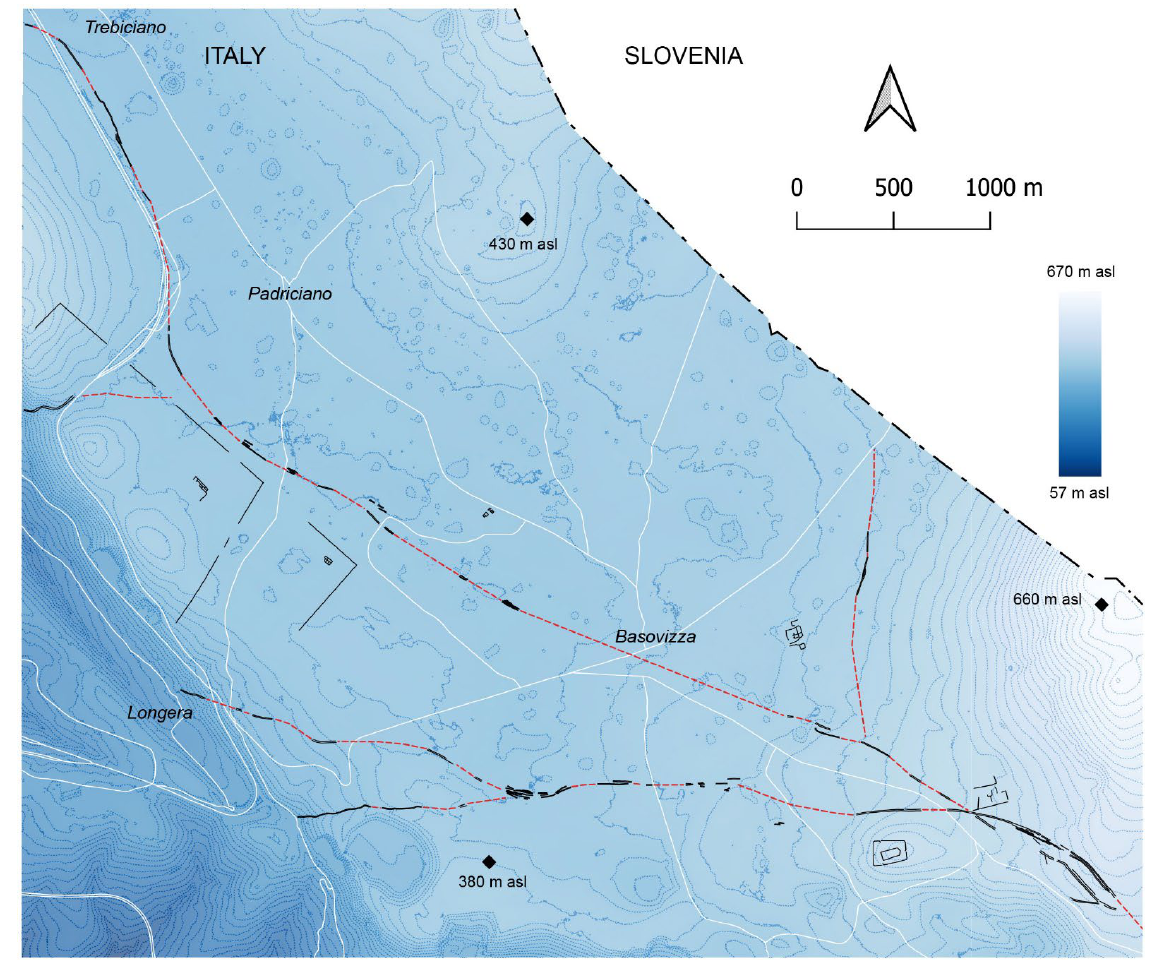
Figure 23. The Roman road network and landscape compared to modern roads indicated by white lines and position of modern villages.